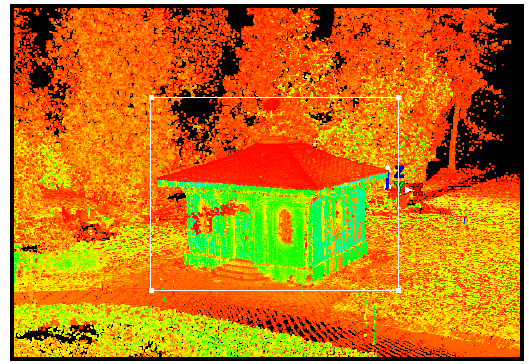
Figure 2: Ultra High Mode Scanning